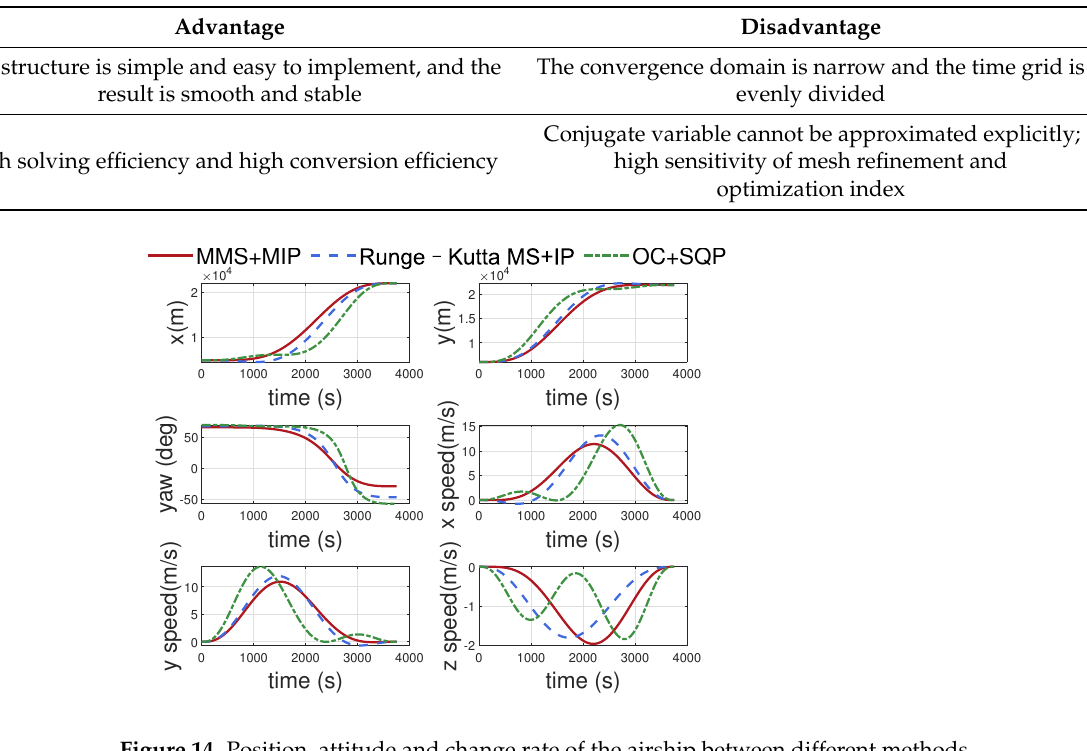
Table 3. Advantages and disadvantages of MS method and OC method.